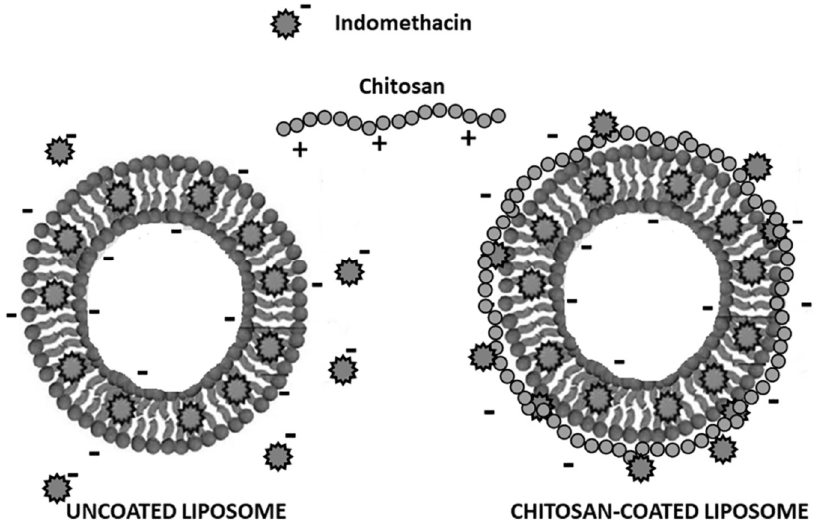
Figure 4. Scheme of structures of uncoated liposome and chitosan-coated liposome vesicles. Adapted with permission from [129], Elsevier, 2018.